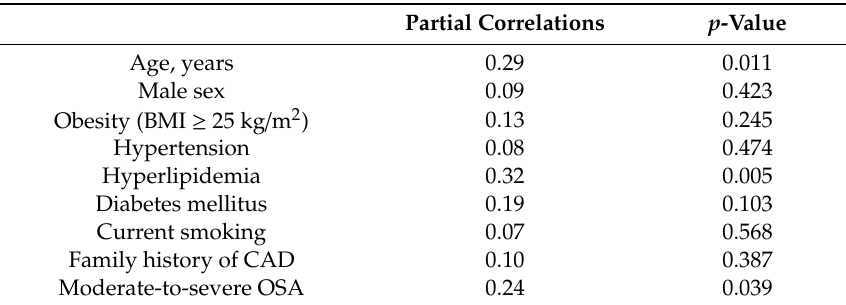
Table 2. Results of multivariable linear regression